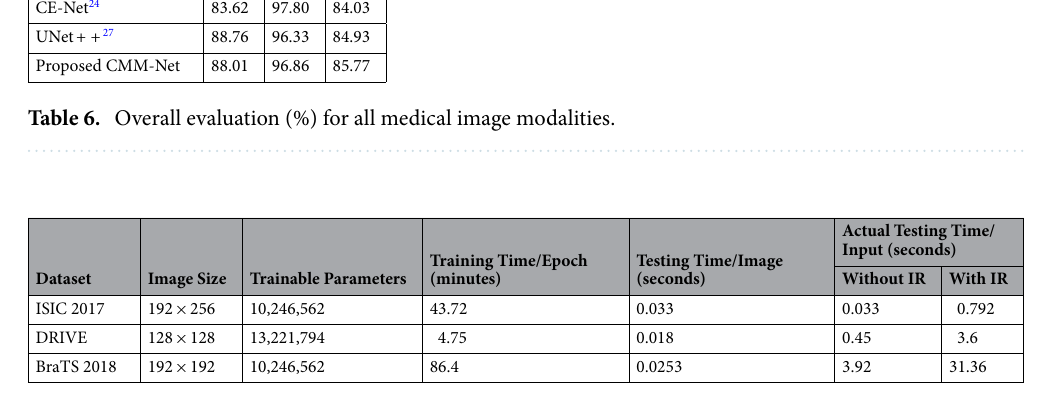
Table 7. Training and testing computation times of our proposed CMM-Net for the three medical benchmarks.